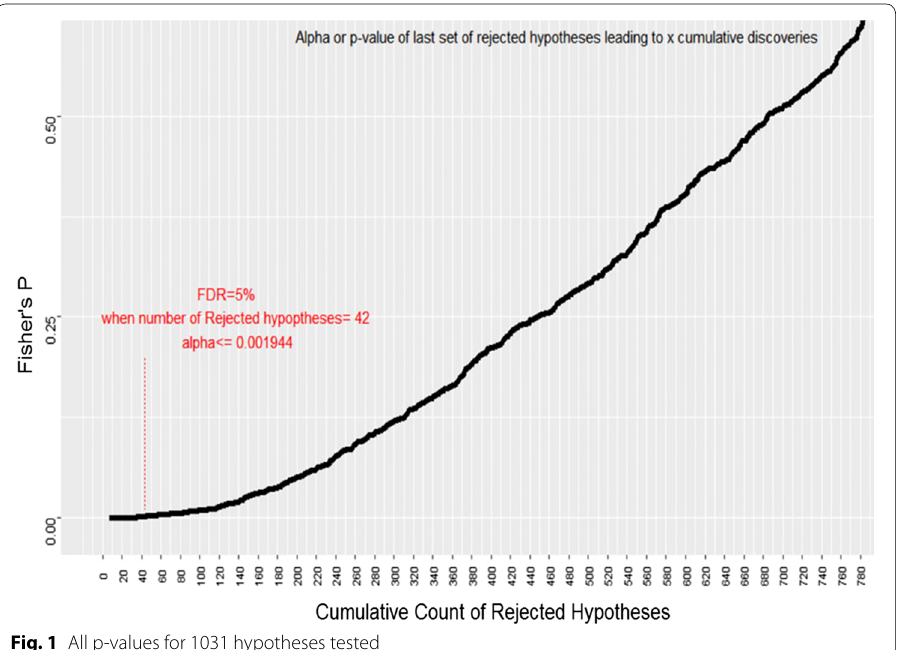
Fig. 1 All p-values for 1031 hypotheses